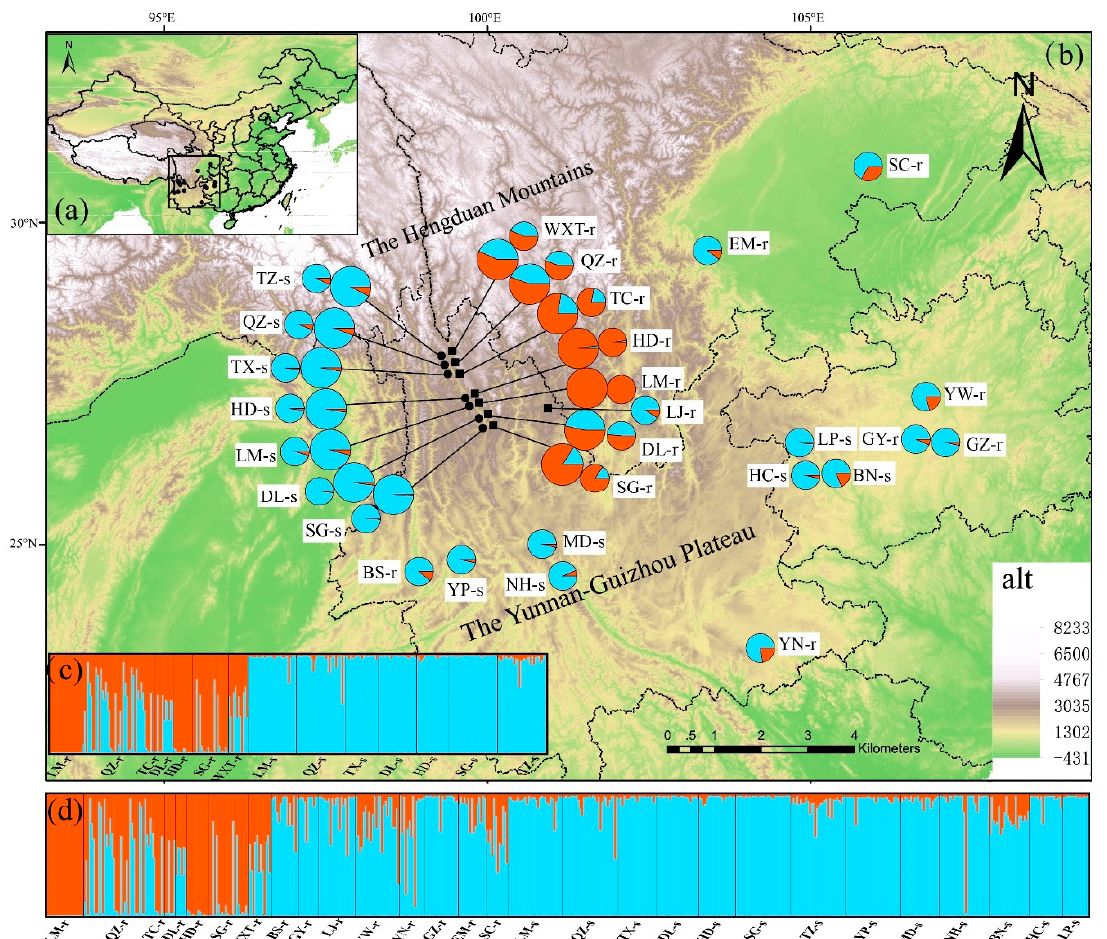
Figure 1. Structure clustering results for 506 individuals from 28 populations of walnut (15 J. regia and 13 J. sigillata ) based on variation at 15 neutral microsatellite loci. ( a ) Map of China showing the region of study. ( b ) Geographic origin of each population sampled and their color-coded grouping ( K = 2 as determined using the deltaK method of Evanno et al. [34]). The location of each pie indicates the sampled locations. The larger pie chart represents the results showing the main sympatric distribution while the smaller pie chart represents the results of all populations. The proportion of colors in each pie chart reflects the proportion of genetic affiliation within each of the two populations as determined by STRUCTURE (averaged over all samples from that location). ( c ) Histogram of individual assignments for seven pairs of main sympatric distributions of J. regia and J. sigillata . ( d ) Histogram of individual assignments for all populations. Dark blue vertical lines separate the different populations as indicated by the codes below the histogram.